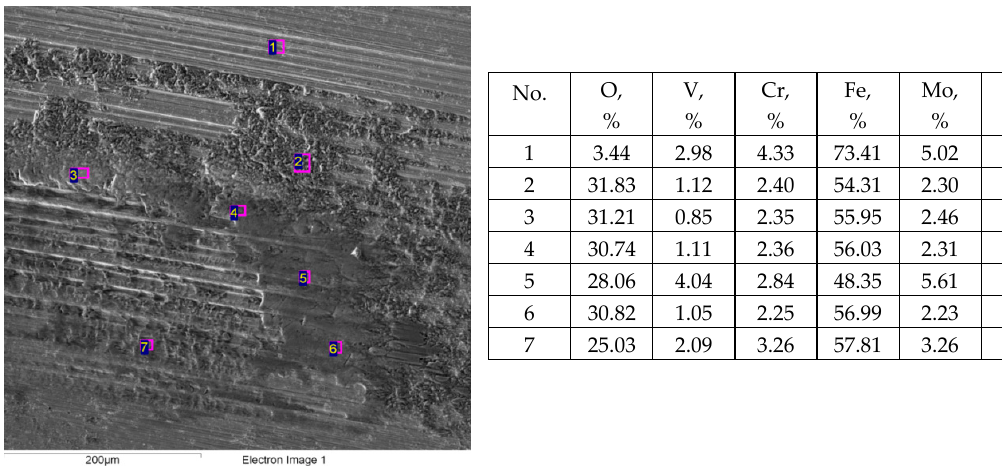
Figure 11. Energy dispersive spectrometry (EDS) analysis of worn lapped disc L after test A; s = 0.2 mm, P = 45 N, f = 20 Hz.